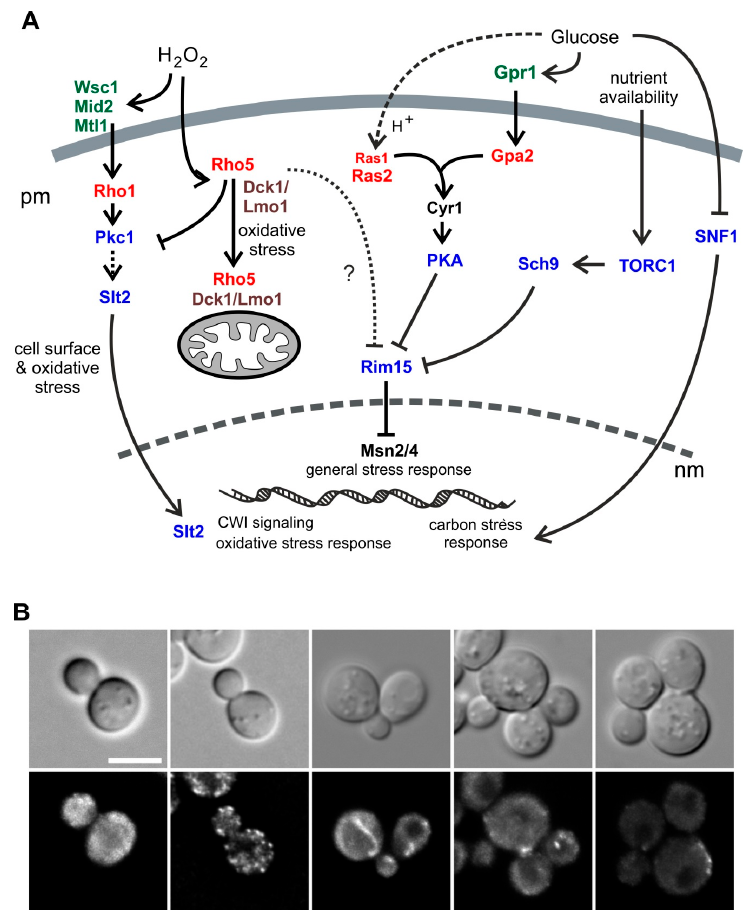
Figure 1. Rho5 in yeast physiology and different distribution patterns of its Dck1 GEF (GDP/GTP exchange factor) subunit. ( A ) Overview on Rho5 and its dimeric GEF in potential interactions with other small GTPases in S. cerevisiae discussed in this work. Arrows indicate activation, lines with bars indicate inhibition of the effectors/pathways. pm = plasma membrane, nm = nuclear membrane. ( B ) Examples for alternative distributions of Dck1 in growing yeast cells. The top lane shows bright field images, the lower lane fluorescent images visualizing Dck1-EGFP (GFP optimized for use in eukaryotic cells). Scale bar = 5 µm.